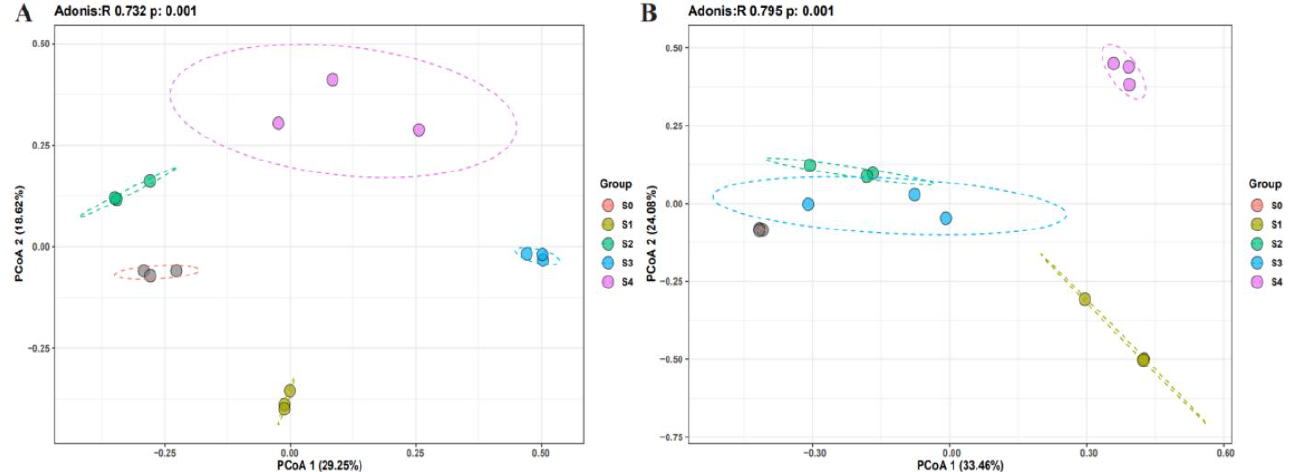
Figure 2. Principal coordinate analysis (PCoA) plot of the first two principal components based on bacterial ( A ) and fungal ( B )community compositions at each successional stage.